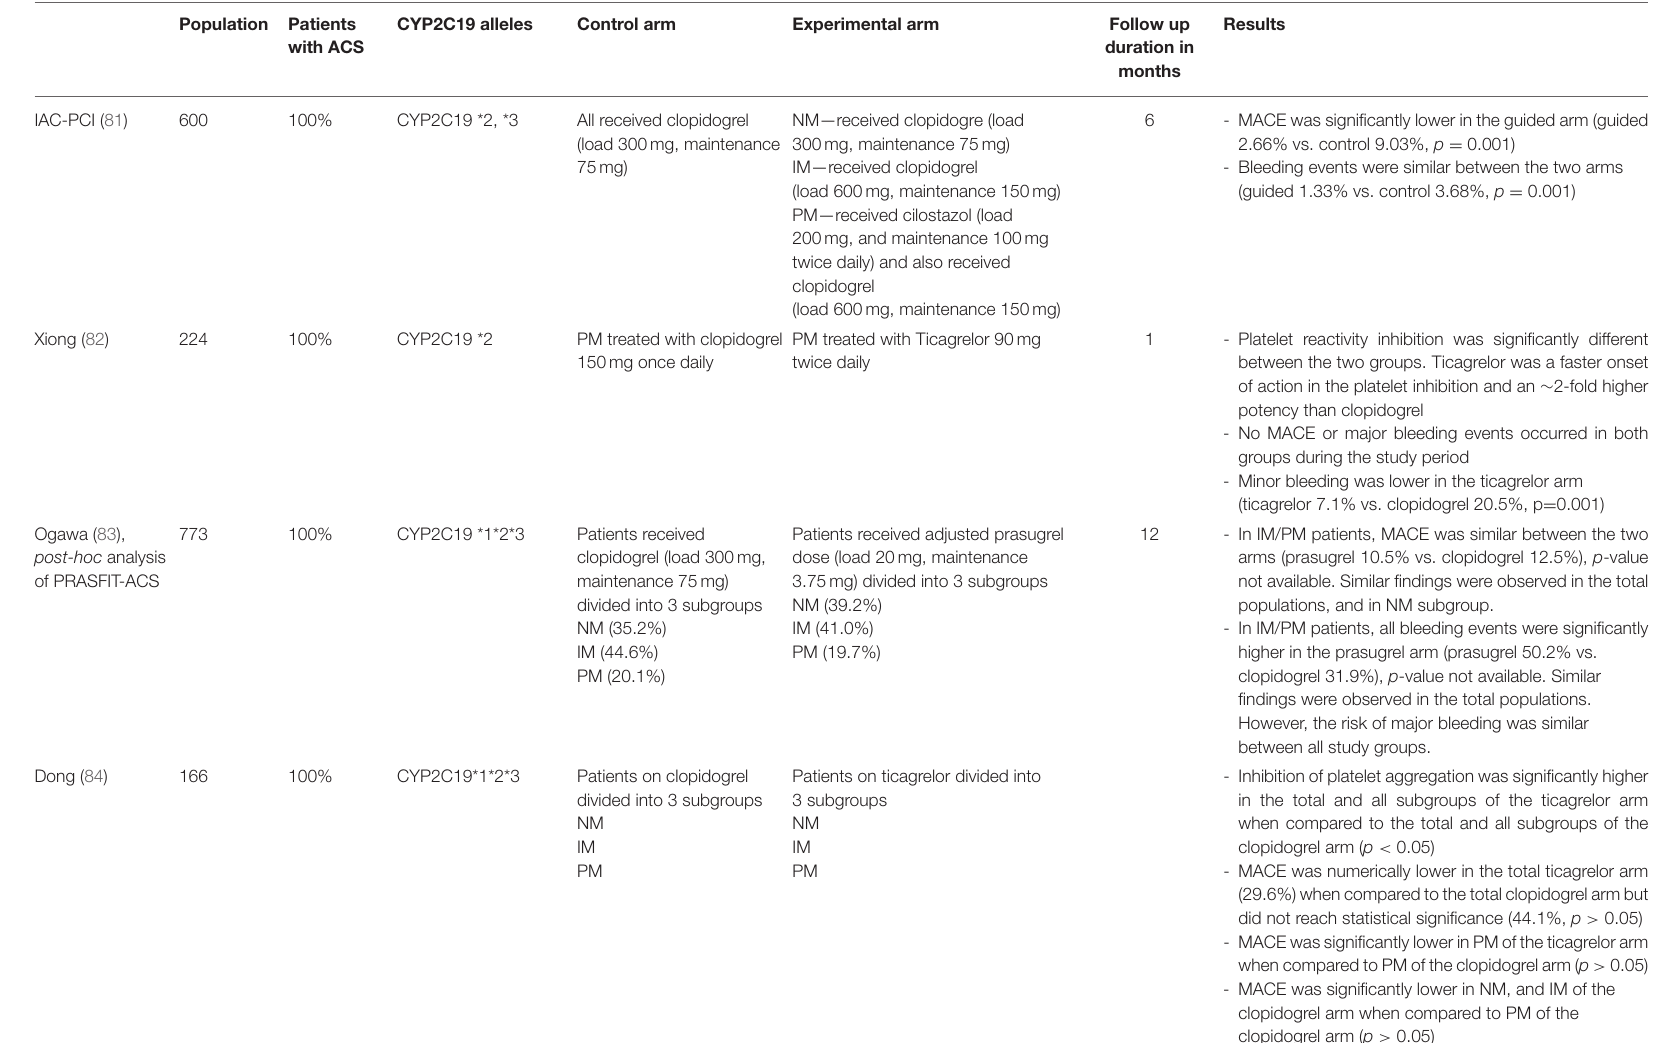
TABLE 4 | Summary of randomized control trials that compared clinical outcomes based on genotype-guided P2Y12 inhibitors. Population Patients with